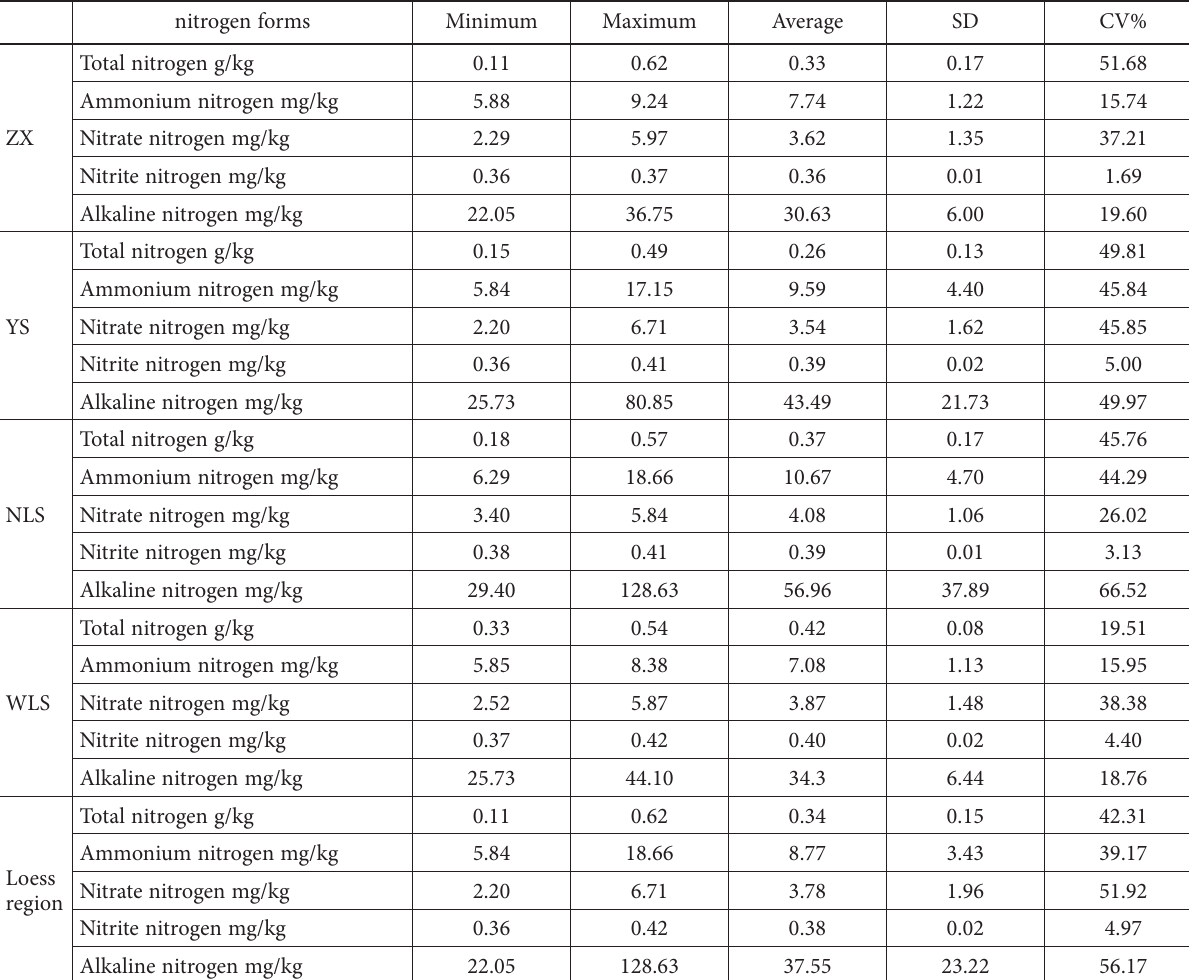
Table 4. Statistical analysis of nitrogen forms and contents in soil of the loess region (2016) nitrogen